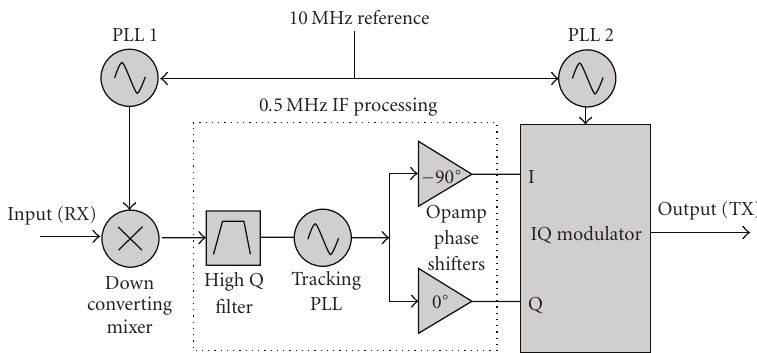
Figure 13: Schematic of the IQ modulator-based phase conjugator.